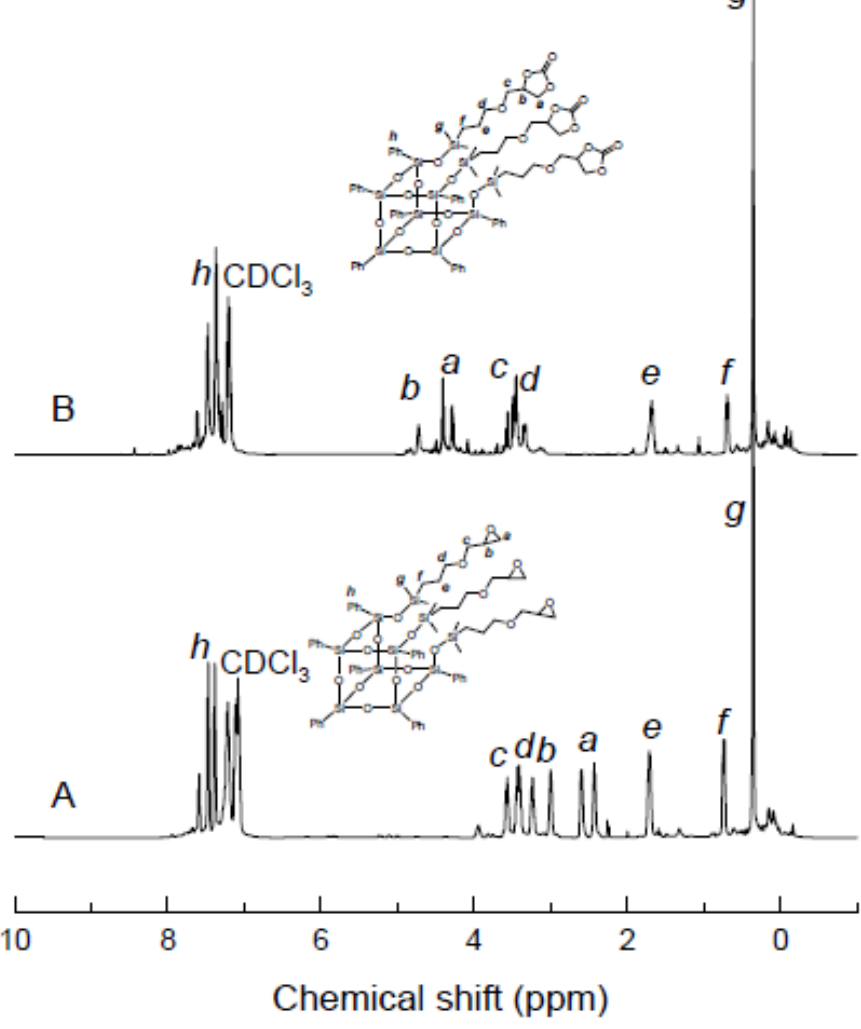
Figure 2. 1 H NMR spectra: ( A ) POSS-3epoxide; ( B ) POSS-3(5CC).